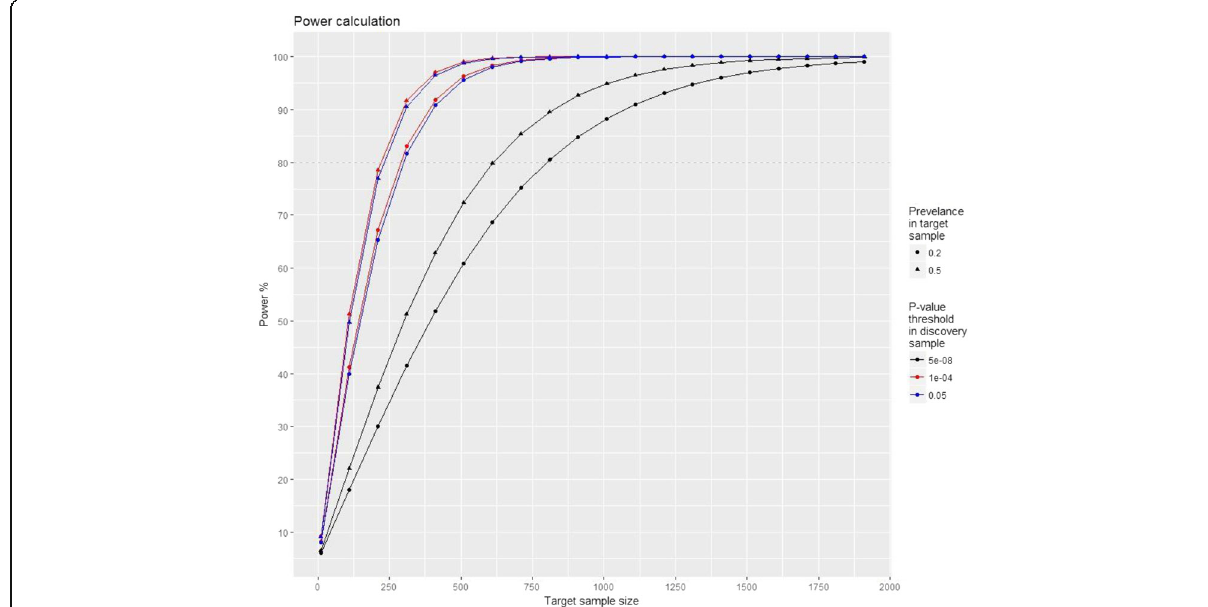
Fig. 1 AVENGEME [7] was used to calculate the study power (y-axis) given different target sample sizes (x-axis) for migraine. For the calculation we used assumptions derived from Gormley et al.: Discovery cohort = 375.000; variance explained in the discovery sample = 0.1463; and a prevalence of 0.158. Further, we assumed that the fraction of NULL SNPs is 0.95 and that the outcome is binary. The effects from Gormley et al. are used to weigh the SNPs for calculating the PRS. We present six curves representing two different prevalences of migraine in the target sample (circle = 0.2 and triangle = 0.5) given three different P T in the discovery sample (black = 5 × 10 − 8 , red = 1 × 10 − 4 , and blue = 0.05